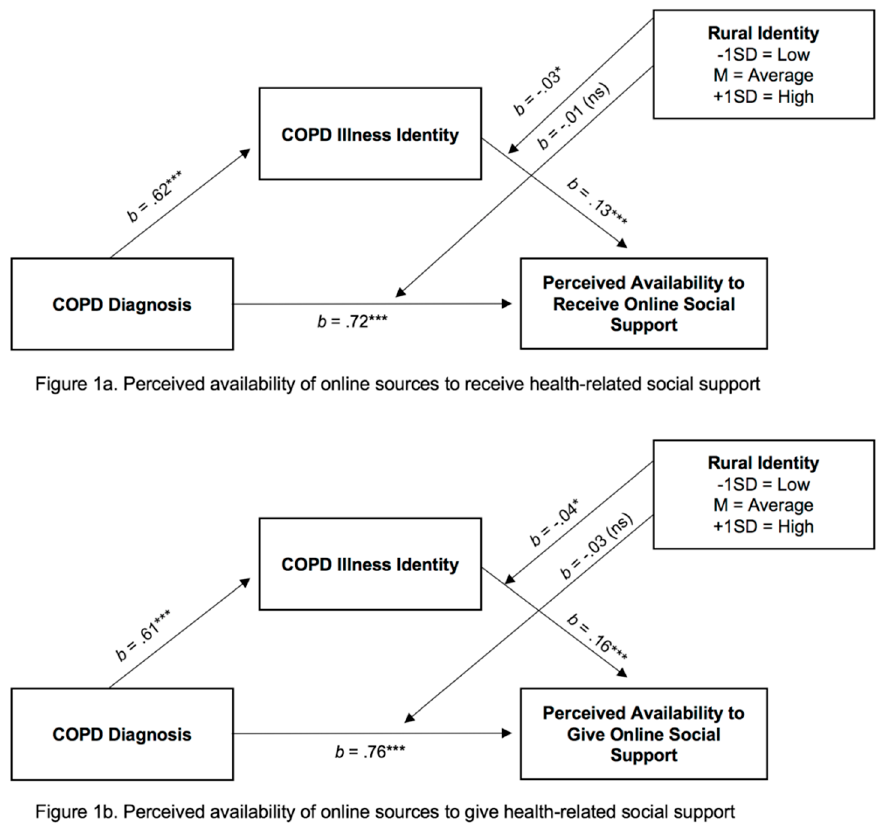
Figure 1. Conceptual models depicting moderated indirect e ff ects. ( a ) Perceived availability of online sources to receive health-related social support; ( b ) Perceived availability of online sources to give health-related social support. Note. * p < 0.05; *** p < 0.001; ns = not statistically significant ( p >